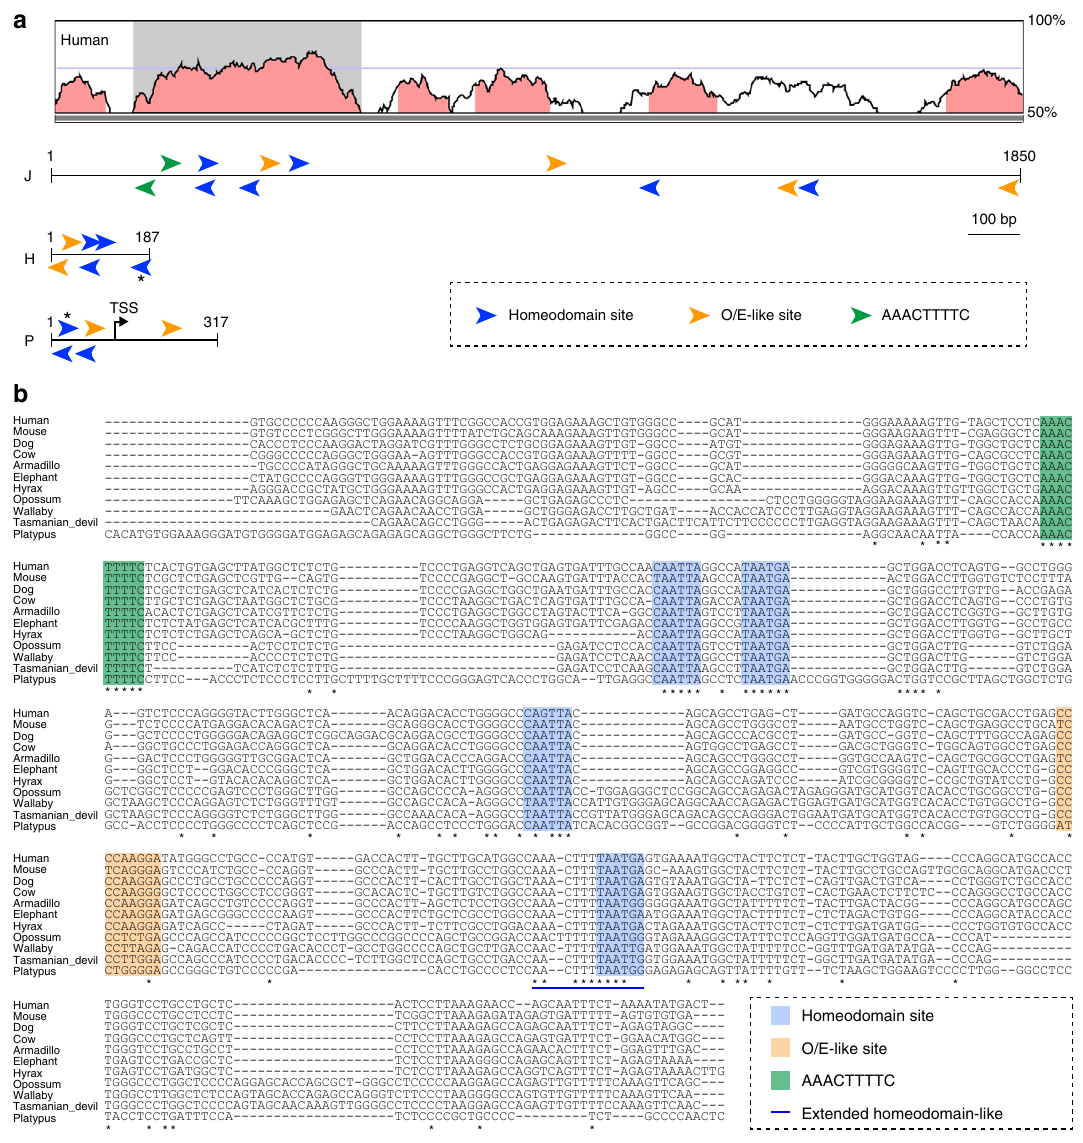
Fig. 6 Conserved sequence motifs in the J element. a Schematic illustration of putative binding motifs of the homeodomain site (TAATKR; blue arrowheads ), an O/E-like site (YYYCARRRR; orange arrowheads ), and a class I-speci fi c conserved motif, the AAACTTTTC site ( green arrowheads ) in the J, H, and P elements in mice. The asterisks represent the extended homeodomain site (5 ′ -AACTTTTTAATGA-3 ′ ). The orientation of the motifs on either DNA strand is represented by arrowheads pointing in different directions. The VISTA plot between mouse and human is shown at the top . The shaded box represents the core J element with highest homology; it contains multiple conserved motifs. b Multiple alignment of a 430-bp sequence, the core J element ( shaded box in a ), from eleven mammals, including placental and aplacental mammals. Comparison of the sequences reveals six stretches of homology, which are indicated by colored boxes : one AAACTTTTC sequence ( green box ), four potential homeodomain sites ( blue ), and one O/E-like site ( orange box ). The blue line depicts a stretch of additional sequence homology upstream of the homeodomain called the extended homeodomain-like